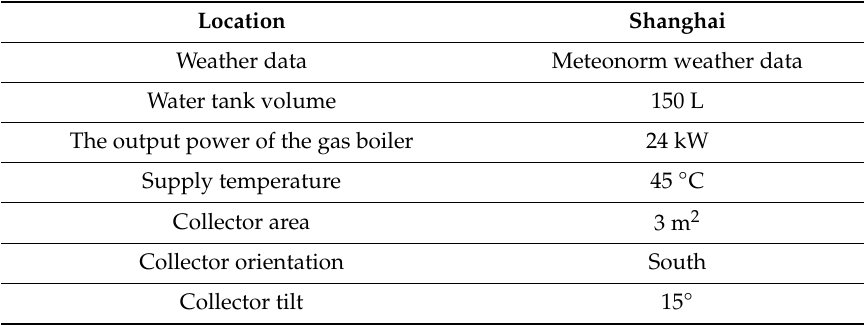
Figure 13. The PolySun model to calculate the solar fraction for CPCs and FPCs. Table 10 The input parameters of the PolySun models. Table 10. The input parameters of the PolySun models.